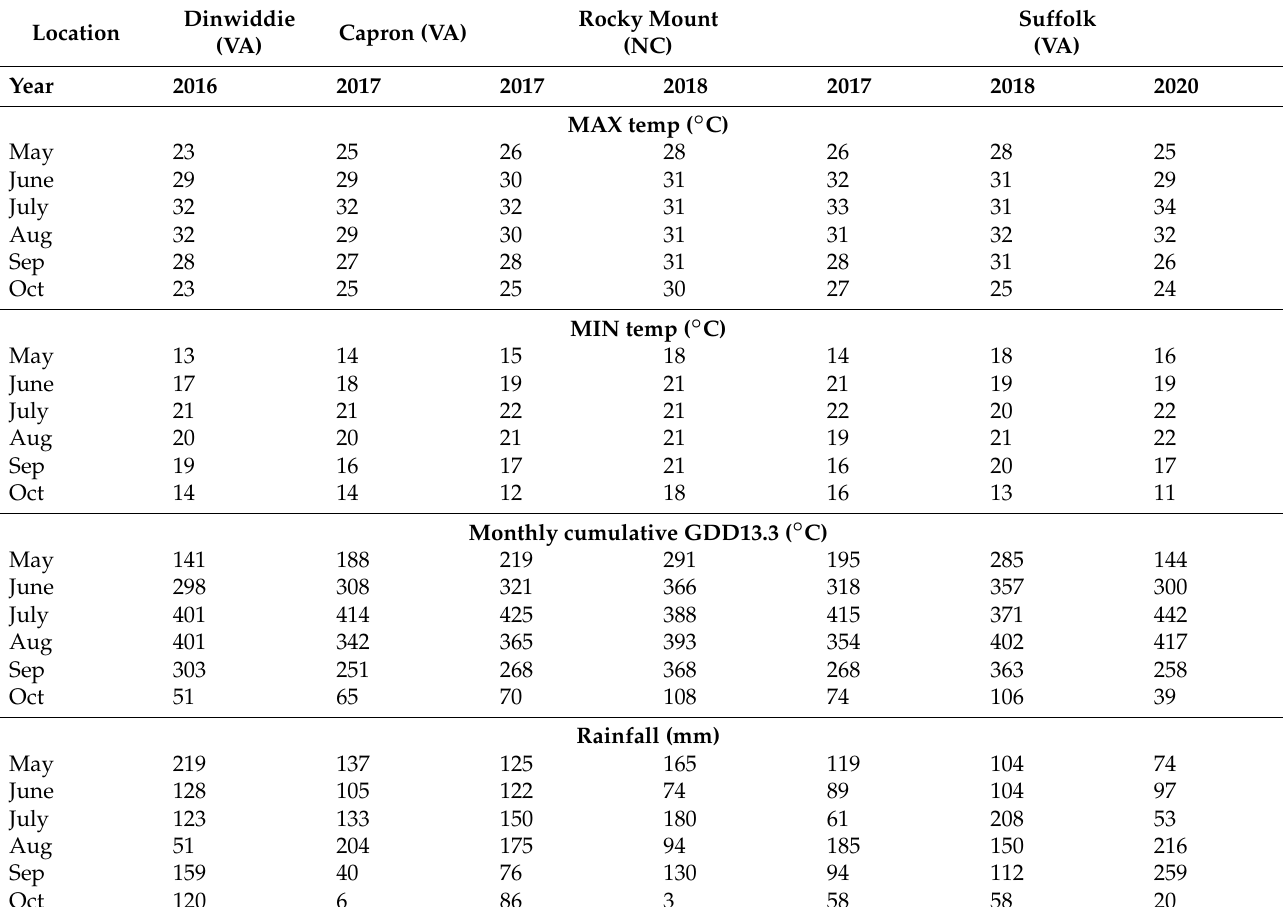
Table 3. Weather information from seven environments (locations and years) recorded during